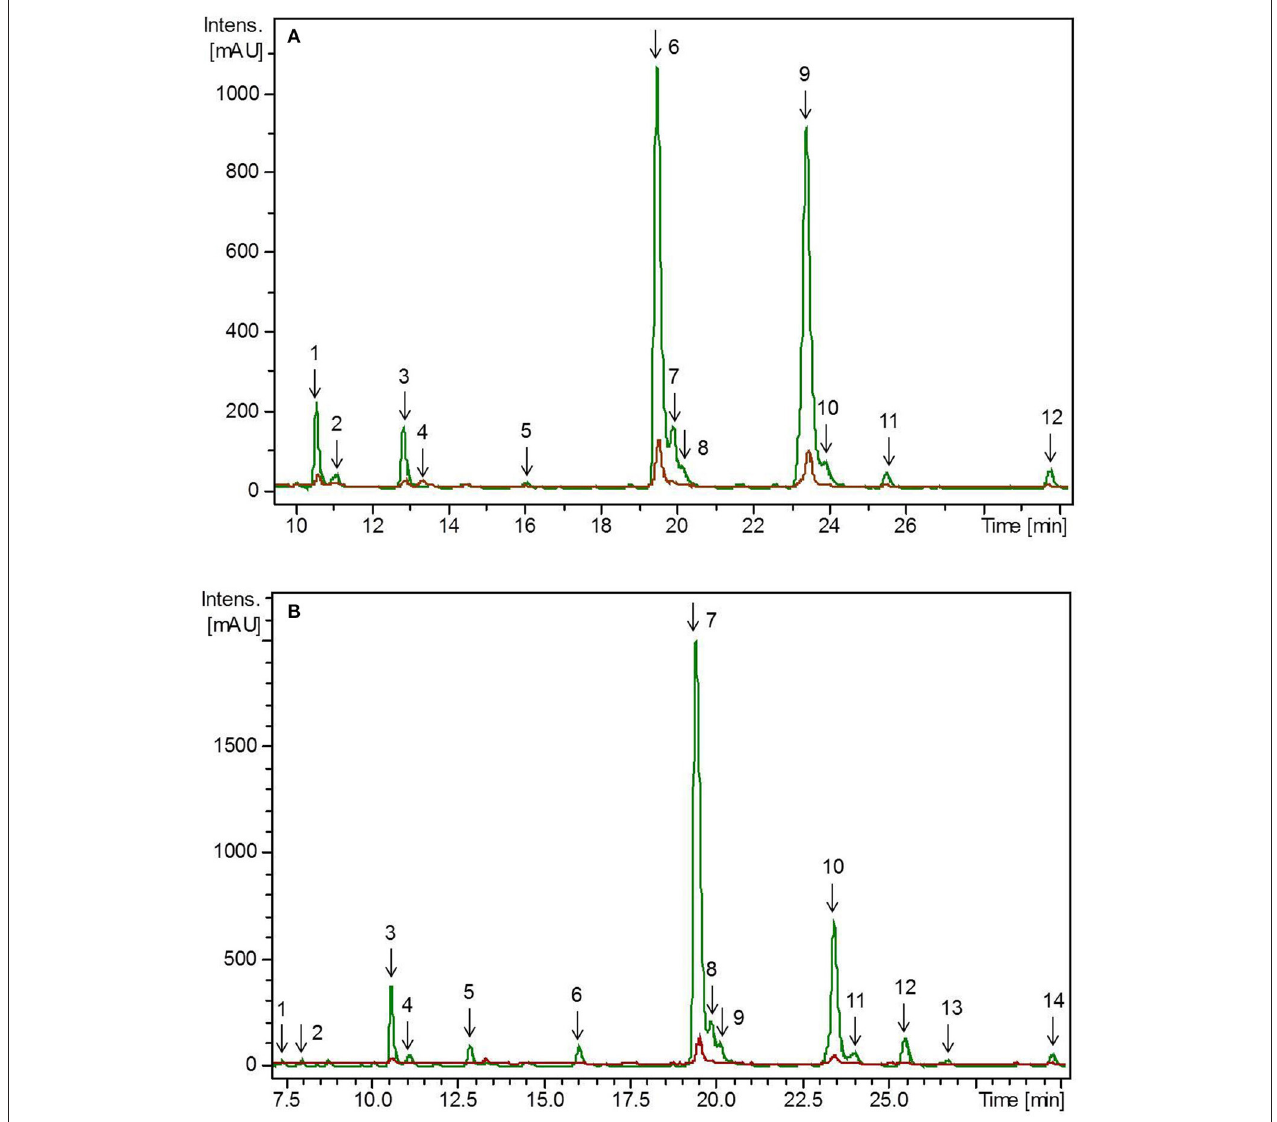
FIGURE 1 | HPLC-chromatogram of flavonoid glycosides in (A) pea microgreens (green) vs. pea microgreen bread (brown) and (B) pea leaves (green) vs. pea leaf bread (brown). Intensity in mAU, extract at 330nm. The bread contains 10.7% plant material, hence a dilution factor of 10.7% has to be taken into account. (A) Compounds are numbered in chronological order 1: Quercetin-3- O -sophorotriose 1, 2: Quercetin-3- O -sophorotriose 2, 3: Kaempferol-3 -O -sophorotriose, 4: Kaempferol-3- O -sophoroside, 4: Quercetin-3- O -caffeoyl-sophorotriose, 5: Quercetin-3- O -coumaroyl-sophorotriose 1, 6: Quercetin-3- O -coumaroyl-sophorotriose 2, 7: Quercetin-3- O -feruloyl-sophorotriose, 8: Kaempferol-3- O -coumaroyl-sophorotriose 1, 9: Kaempferol-3- O -feruloyl-sophorotriose, 10: Quercetin-3 -O -coumaroyl-sophorotriose 3, 11: Kaempferol-3- O -coumaroyl-sophorotriose 2 (B) Compounds are numbered in chronological order 1: Quercetin-3- O -sophorotriose 1, 2: Quercetin-3- O -sophorotriose 2, 3: Kaempferol-3- O -sophorotriose, 4: Quercetin-3- O -sophorotriose 2, 5: Quercetin-3- O -caffeoyl-sophorotriose, 6: Quercetin-3- O -coumaroyl-sophorotriose 1, 7: Quercetin-3- O -coumaroyl-sophorotriose 2, 8: Quercetin-3- O -feruloyl-sophorotriose, 9: Kaempferol-3- O -coumaroyl-sophorotriose 1, 9: Kaempferol-3- O -feruloyl-sophorotriose, 10: Quercetin-3- O -coumaroyl-sophorotriose 3, 11: Kaempferol-3- O -coumaroyl-sophorotriose.